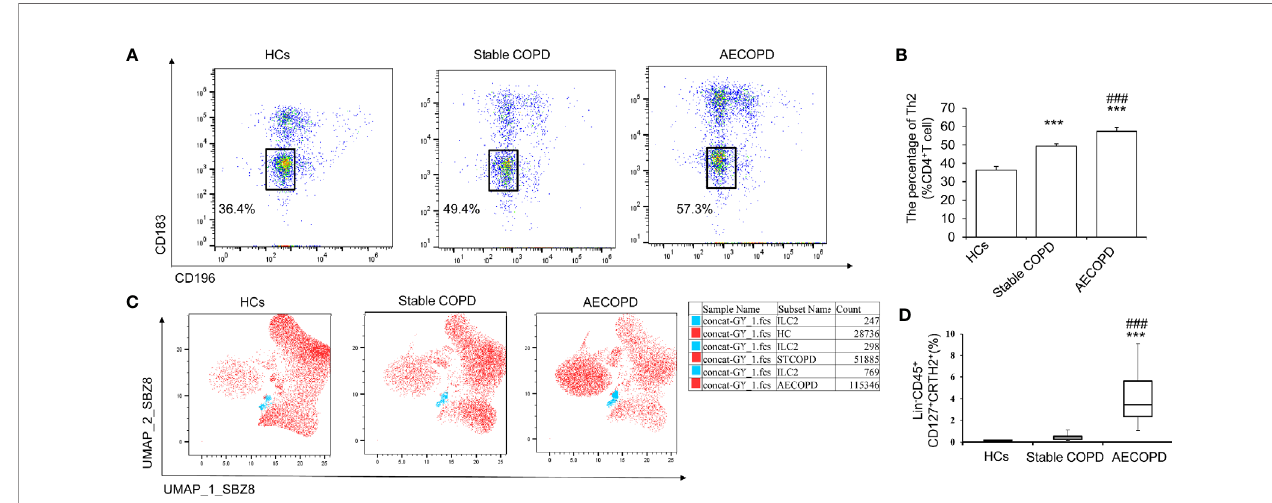
FIGURE 1 | Th2 and ILC2 cells in different groups. Th2 cells and ILC2 cells in healthy control group, stable COPD group and AECOPD group were analyzed by fl ow cytometry. (A) Th2 (CD183 − CD196 − ) was labeled with speci fi c antibodies and quanti fi ed in each groups. (B) Percentage of Th2 cells. (C) Uniform manifold approximation and projection (UMAP) analysis of ILC2 cells in peripheral blood among the three groups. (D) Percentage of ILC2s in three groups. Data are shown as mean ± SEM. n=50. *** P < 0 001, compared with the control group. ### P < 0.001 compared with the stable COPD